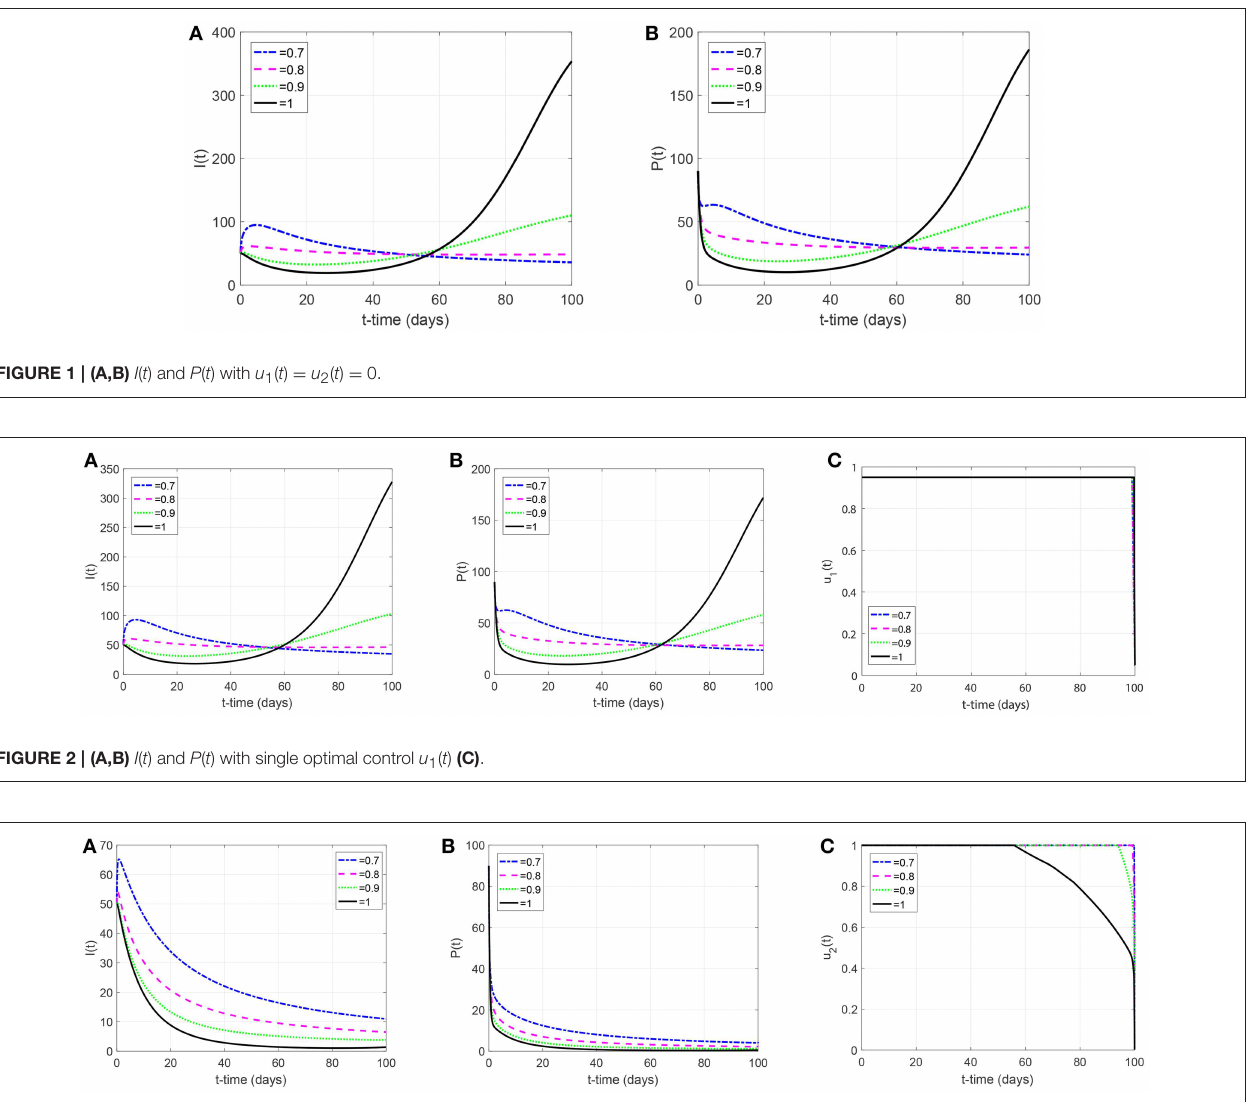
FIGURE 3 | (A,B) I ( t ) and P ( t ) with single optimal control u 2 ( t ) (C)